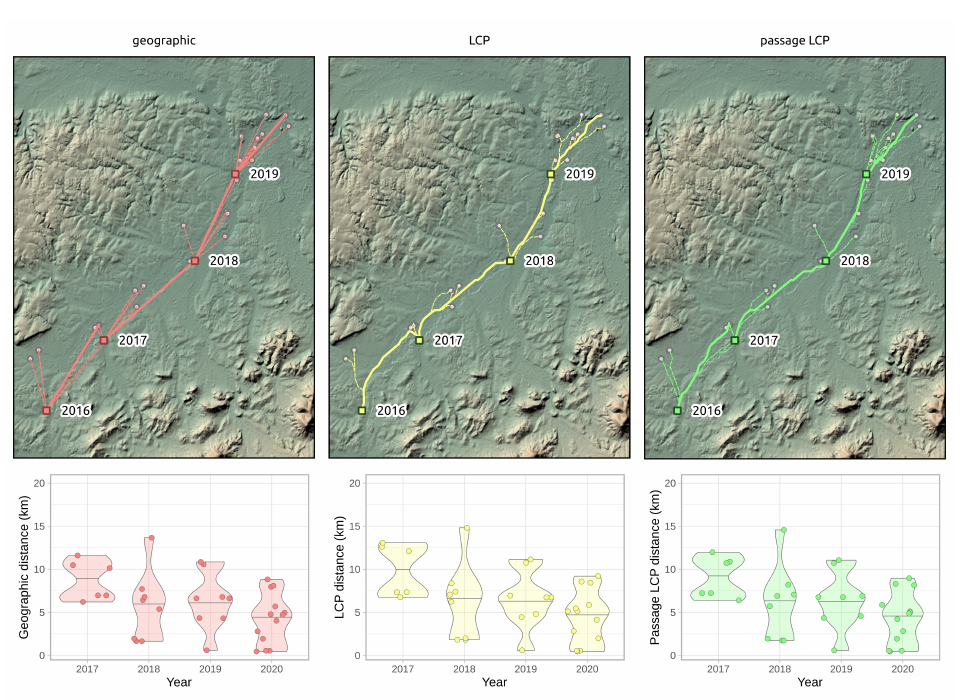
Figure 7. Annual paths of R. nitidula spread in the Odra River basin and distribution and median of distances as indicated by three methods for determining paths and distances (geographic, LCP, and passage LCP). Squares indicate origin points in a given year, and highlighted lines represent the path with the highest calculated